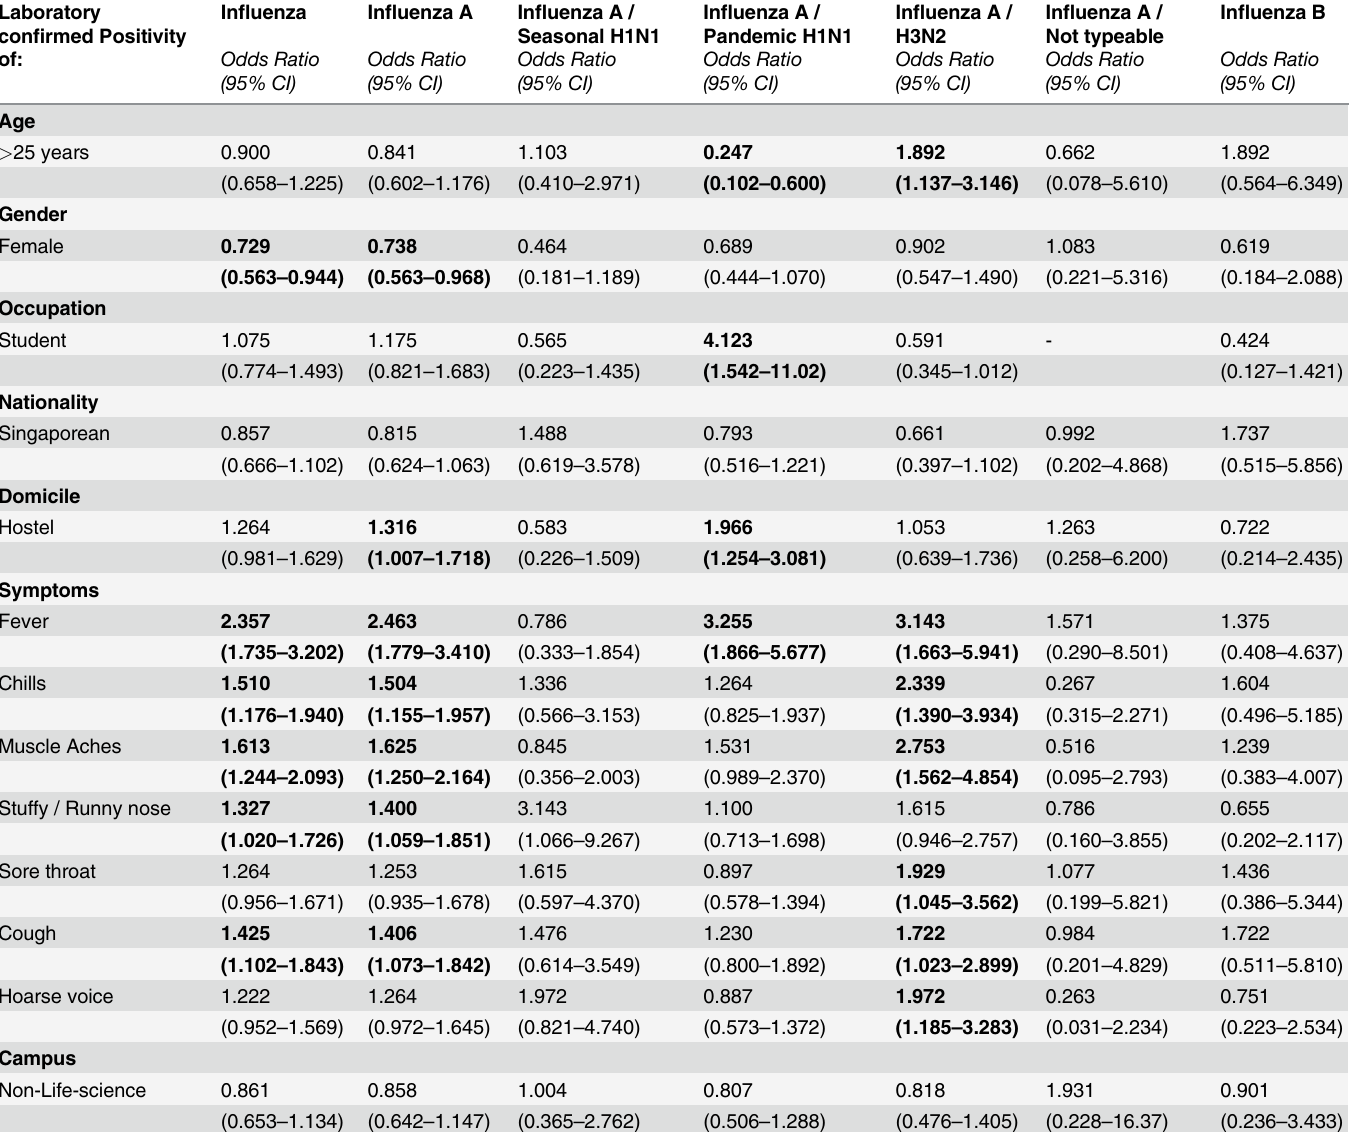
Table 4. Risk factors for In fl uenza